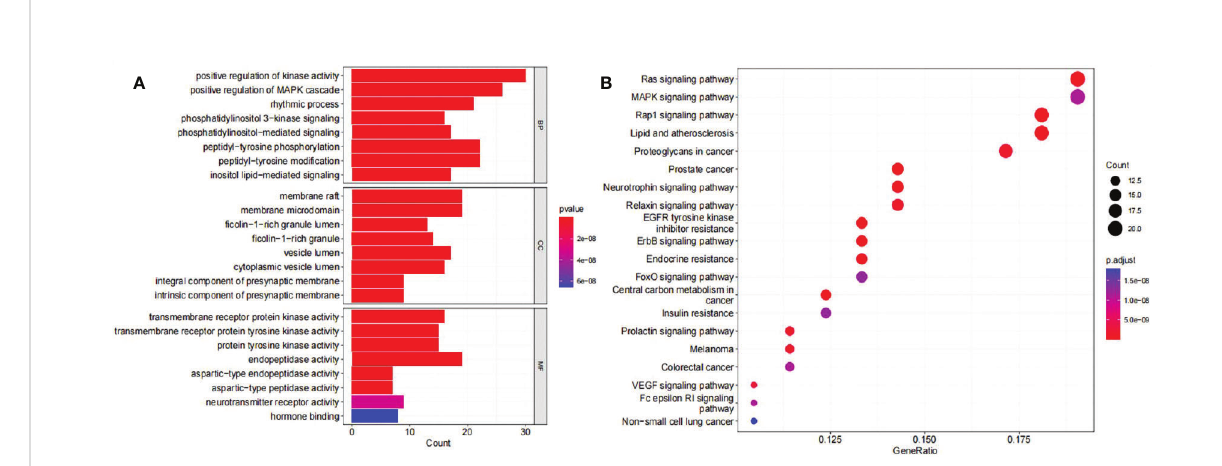
FIGURE 6 Analysis of potential targets of 4m for AD treatment based on GO and KEGG enrichment. (A) GO enrichment analysis identi fi ed genes involved in GO-BP analysis, GO-CC analysis, GO-MF analysis; (B) KEGG pathway analyses from bioinformatics data for the molecular signal pathway).